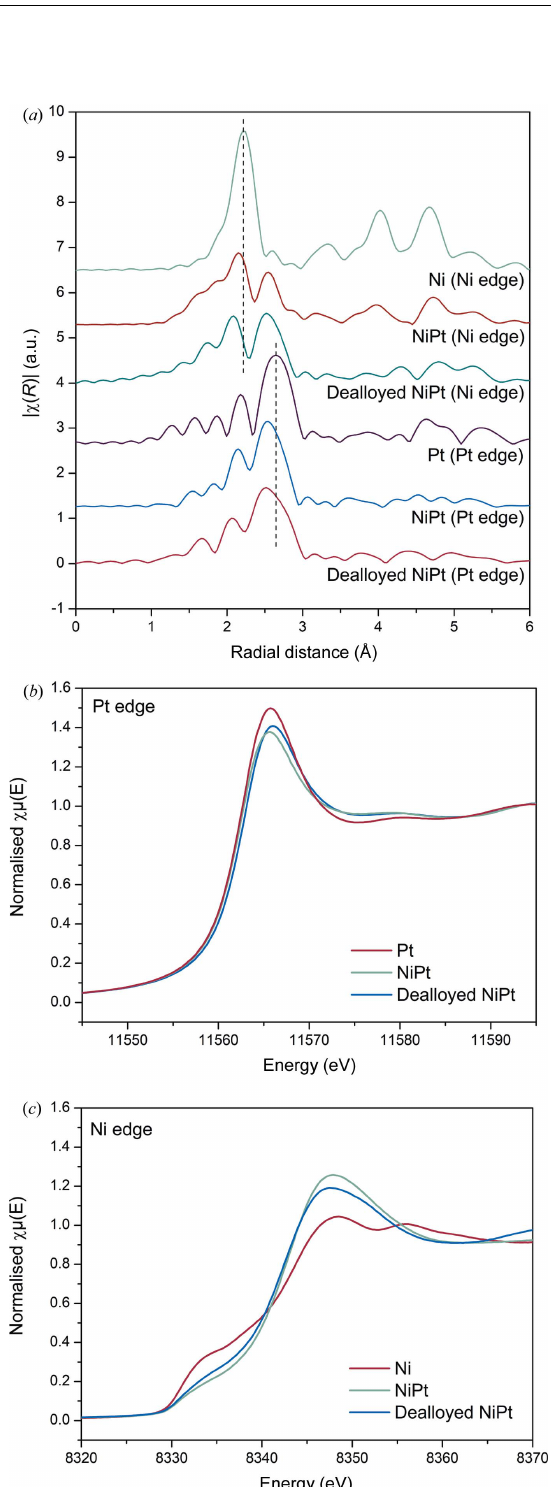
Figure 7 ( a ) EXAFS Ni- and Pt-edge comparison of the NiPt and dealloyed NiPt nanoparticles, and XANES plots of ( b ) Pt and ( c ) Ni.